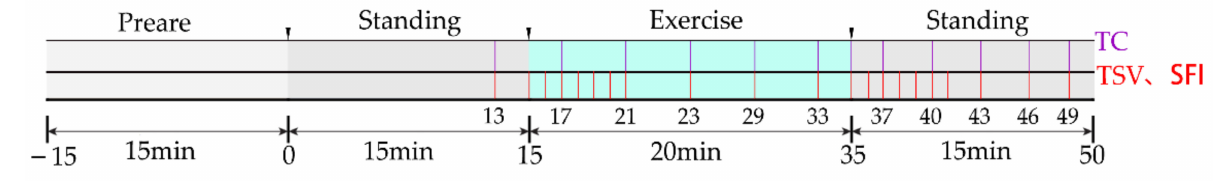
Figure 3. Experimental procedure.